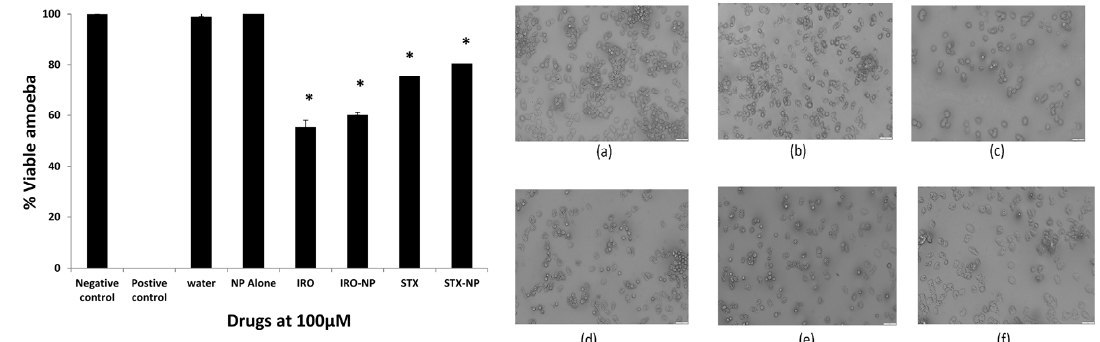
Figure 5. The amoebicidal activity of drugs was tested. All substances exhibited significant amoebicidal effects at the concentration of 100 µ M post-24 h incubation against the A. castellanii trophozoites. Irosustat (IRO), STX140 (STX), and respective nanoparticles demonstrated significant amoebicidal activity against Acanthamoeba castellanii . The findings are shown as the mean ± sem (* represents p < 0.05). Microscopic analysis of A. castellanii after amoebicidal assay with Irosustat, STX140 and their respective nanoparticles: ( a ) amoeba alone with RPMI (negative control), ( b ) PLGA na- noparticles (placebo) along with amoeba—RPMI mix, ( c ) Irosustat along with amoeba—RPMI mix,